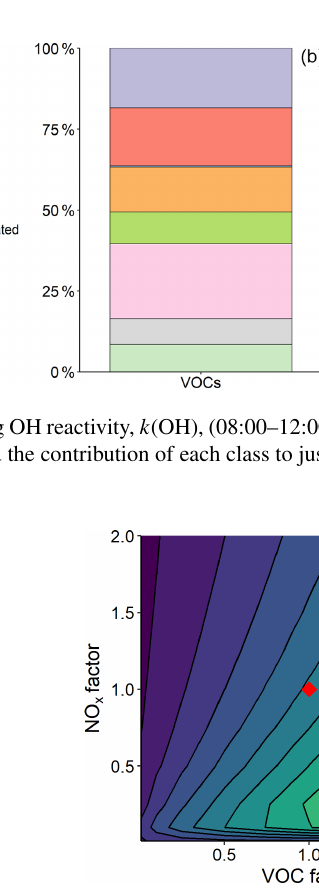
Figure 9. Mean modelled O 3 production, P( O 3 ) , isopleth between 08:00 and 12:00 based on varying VOC and NO x concentrations in the model. The red diamond at point (1,1) represents modelled P( O 3 ) at observed VOC and NO x